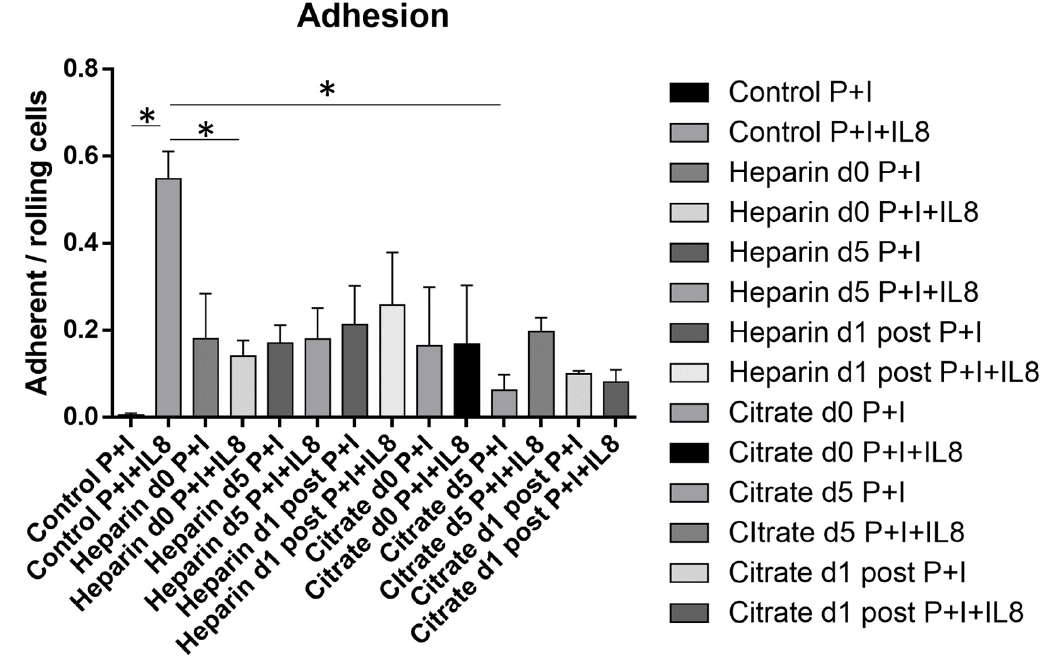
Figure 5. Chemokine-induced leukocyte adhesion. For analysis of chemokine-induced adhesion, whole blood was perfused into microfluidic chambers coated with either P-selectin and ICAM-1 or P-selectin, ICAM-1 and interleukin-8, and the ratio of adhering to rolling leukocytes determined. Control subjects exhibited a significant increase in ratio of adherent to rolling cells, whereas this increase was absent in all AKI-groups, independent of mode or duration of CVVH. (n ≥ 2 individual patients; * p < 0.05; mean ± SEM).